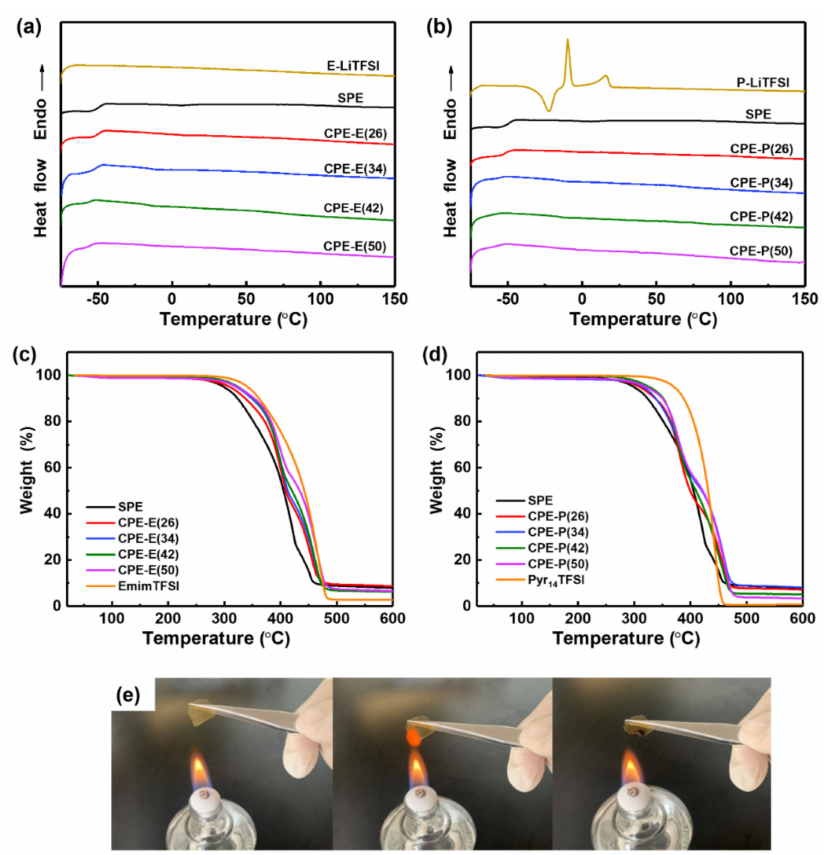
Figure 2. Thermal properties of E/P-LiTFSI solutions, SPE, and different CPEs: ( a , b ) DSC curves. ( c , d ) TGA curves. ( e ) Flammability test of